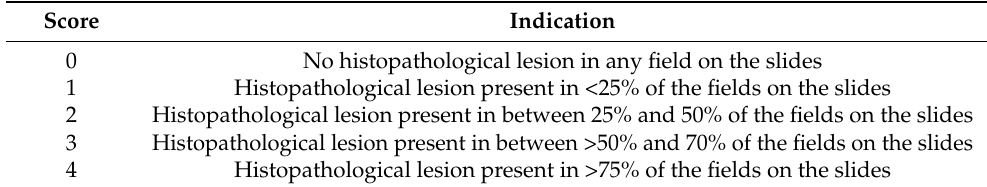
Table 2. Criteria of histopathological